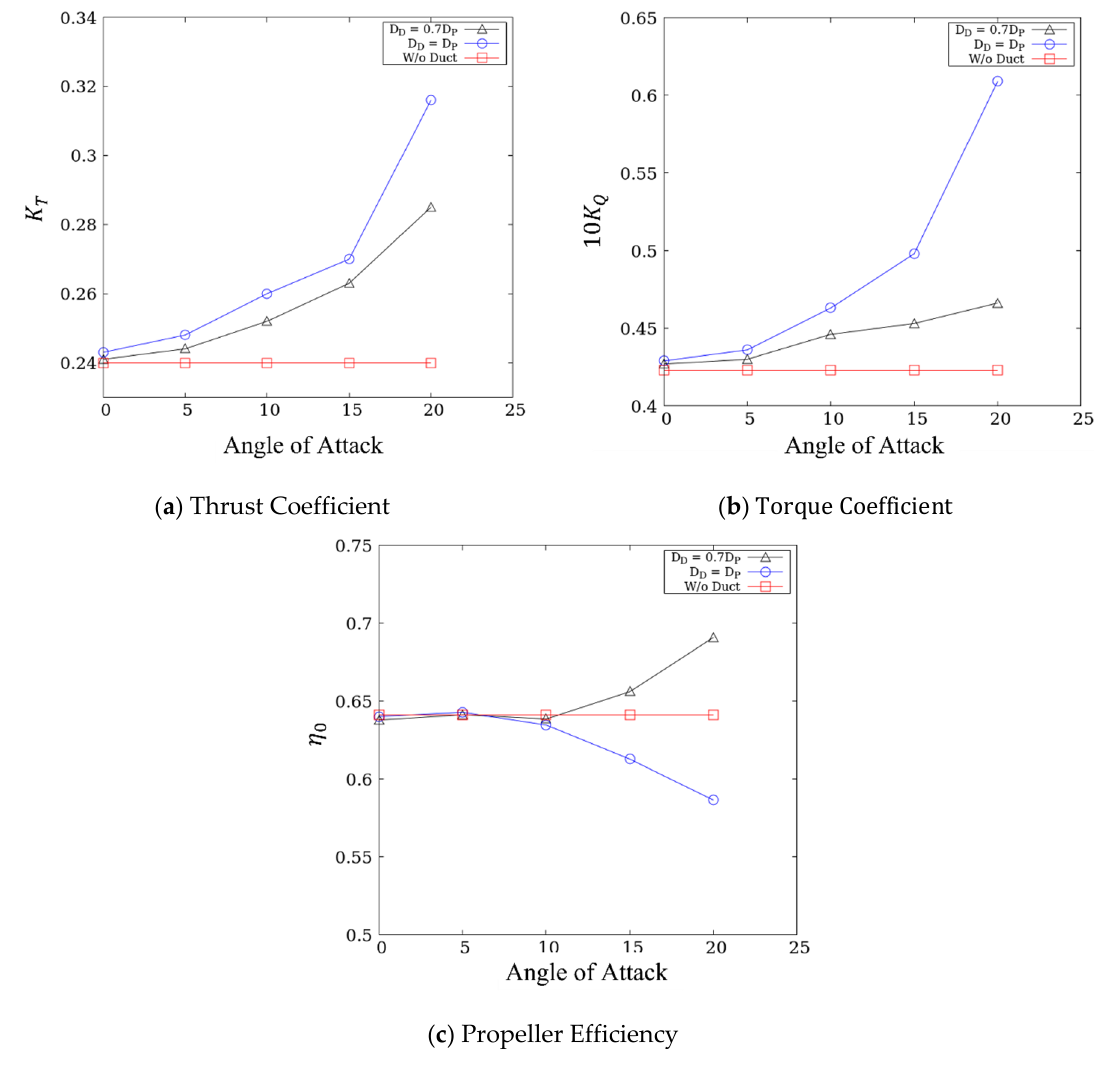
Figure 14. Propeller performance